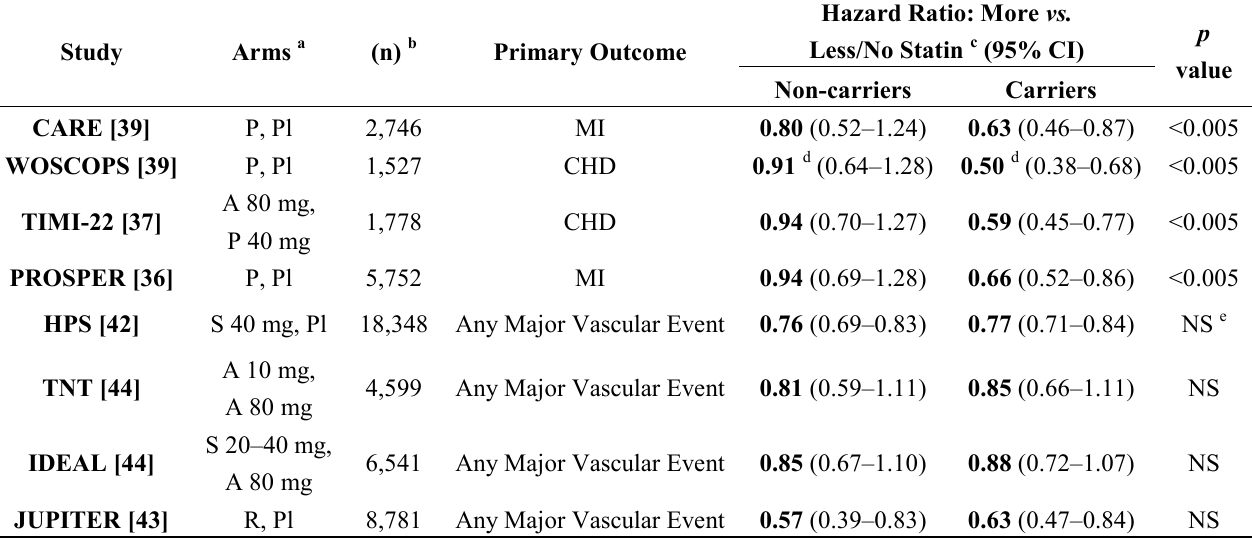
Table 2. KIF6 and Statin